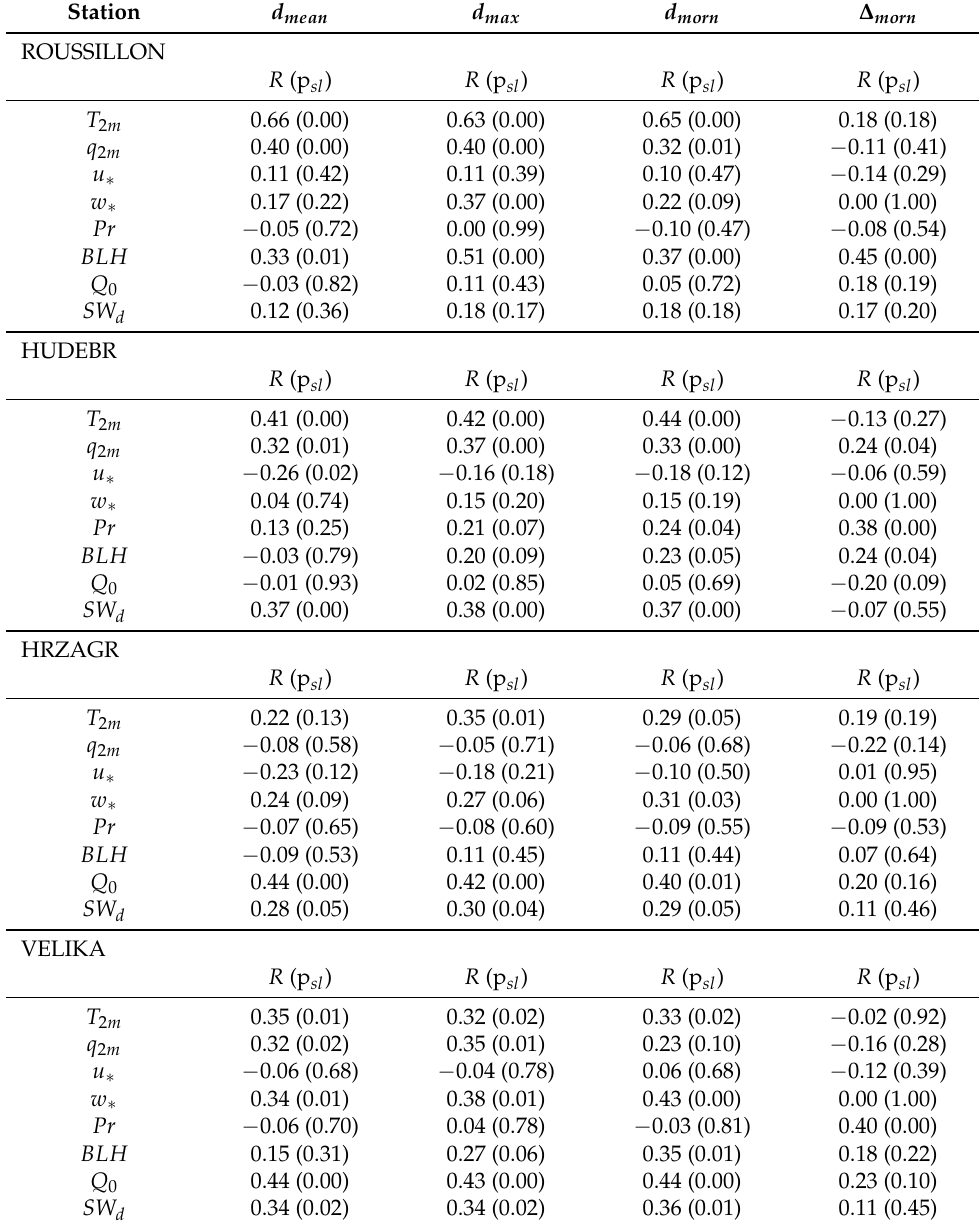
Table 5. Correlation, R, and significance, p sl , between ragweed pollen concentrations and meteoro- logical variables for four stations: ROUSSILLON, HUDEBR, HRZAGR and VELIKA and the year 2010. The definition of the variables and their units are explained in Table